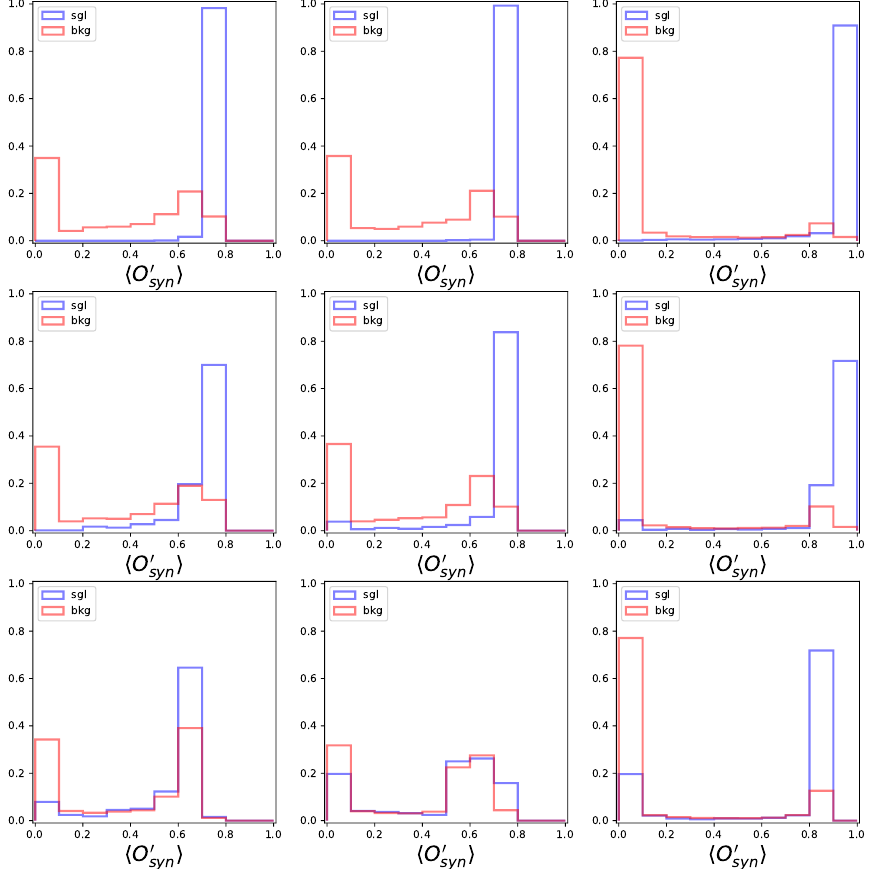
Figure 7 . Novelty score according to hO 0 the same BPs as in figure